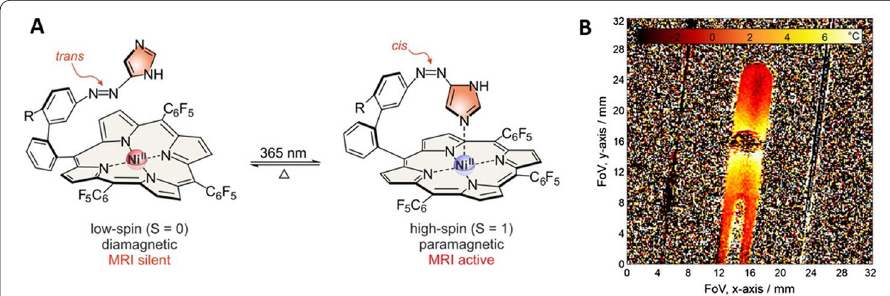
Fig. 1 Photoswitchable MRI CA; A The thermally stable trans isomer can be switched to the metastable cis isomer, which will return to the initial form in a first order thermal process (on the timescale of seconds‑minutes, depending on the temperature). B Temperature map in an NMR tube; polyethyleneimine silica beads coated with the NIR dye indocyanine green (ICG) that were warmed by infrared irradiation to act as a temperature source. (Reproduced with permission from ref. Wellm et al. (2021) under the terms of